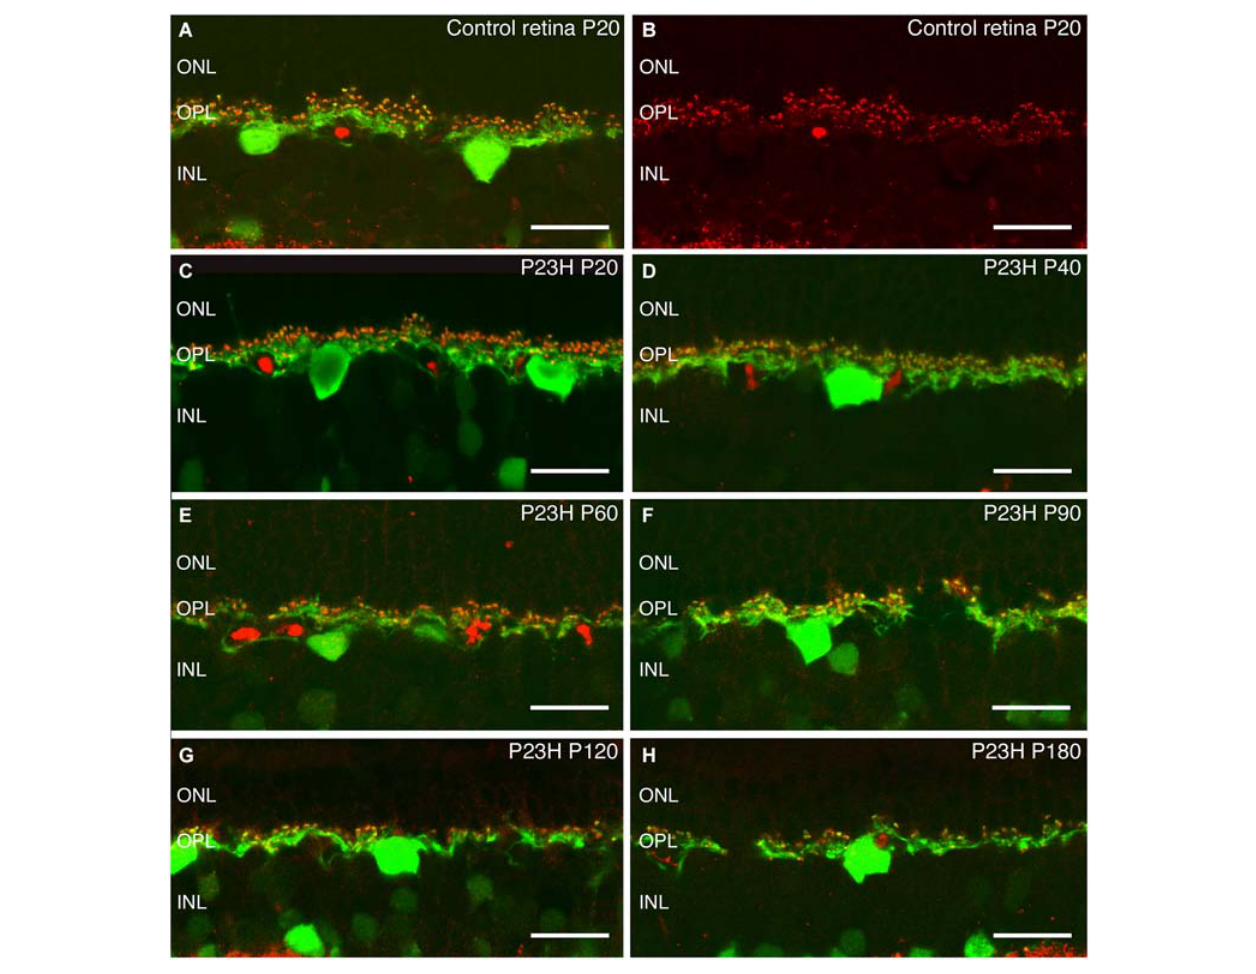
synaptic contacts between photoreceptor and horizontal cells in P23H with age (C–H) , as compared to the normal rat retina (A,B) . ONL: outer nuclear layer; OPL: outer plexiform layer; INL: inner nuclear layer. Scale bar: 20 µ